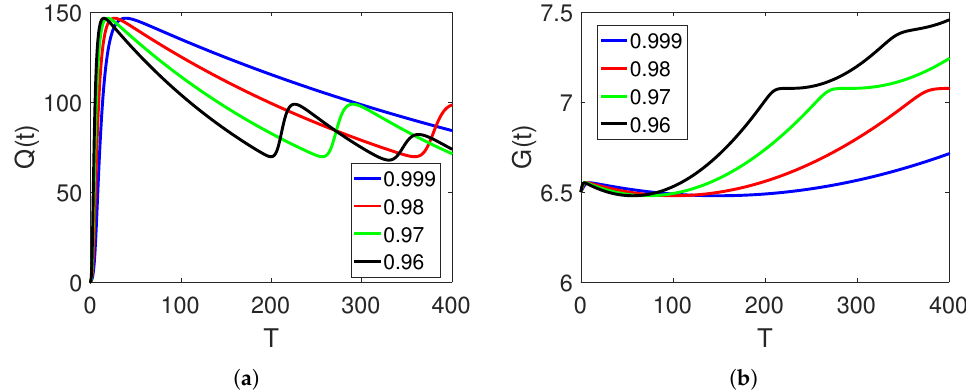
Figure 6. Dynamical behavior of the recovered class ( a ) and isolated class ( b ) on different arbitrary fractional order ς on sub interval [ 0, t 1 ] and [ t 1 , T ] of [ 0, T ] for different time duration.